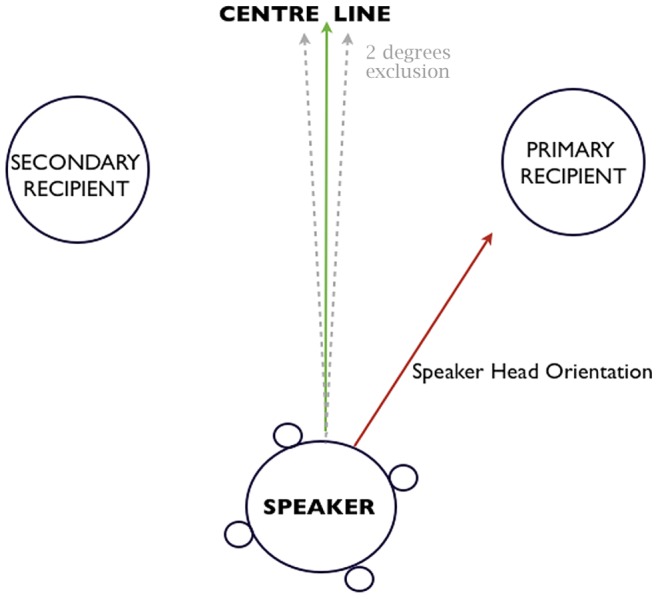
Indexing primary and secondary recipient from the head angle of the speaker.Speaker’s head angle is derived from the precise positions (3D) of the four reflective markers attached to their cap.